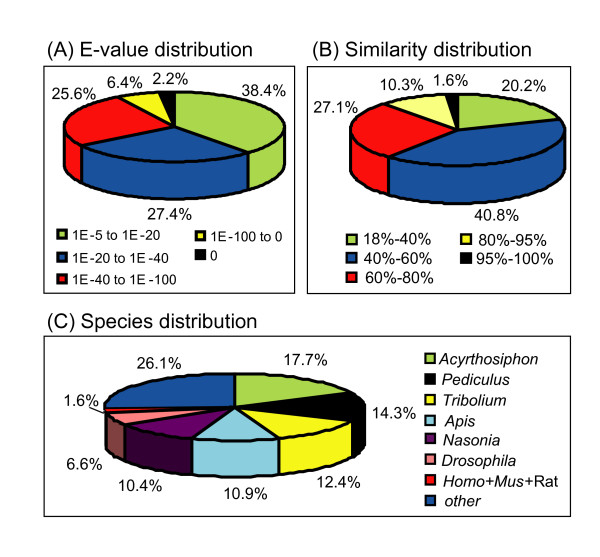
Characteristics of homology search of assembled sequences against the nr database. A. E-value distribution of best BLASTx hits for each distinct sequence with a cut-off E-value of 1.0E-5. B. Similarity distribution of the best BLAST hit for each sequence. C. Species distribution is shown as a percentage of the total homologous sequences with an E-value of at least 1.0E-5. We used the first hit of each sequence for analysis. Homo: Homo sapiens; Mus: Mus musculus; Rat: Rattus norvegicus.